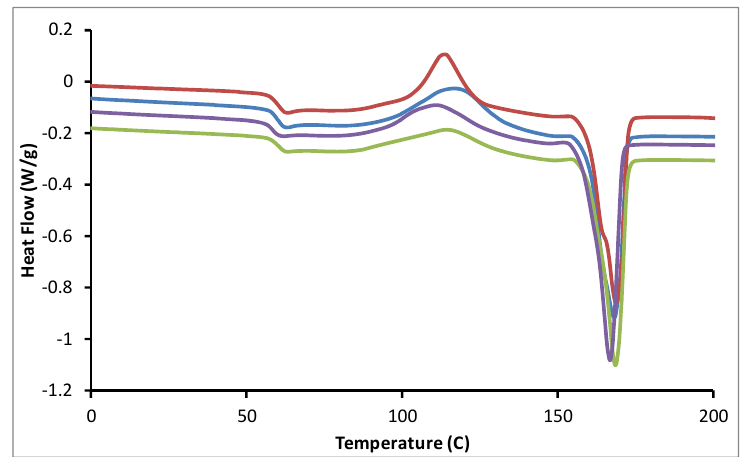
Figure 9. Representative DSC thermograms of PLA and PLA modified with 5% TanHex before and after artificial weathering exposure (exo up). PLA (red), PLA-exposure (green), TanHex (blue) and TanHex-exposure (purple).